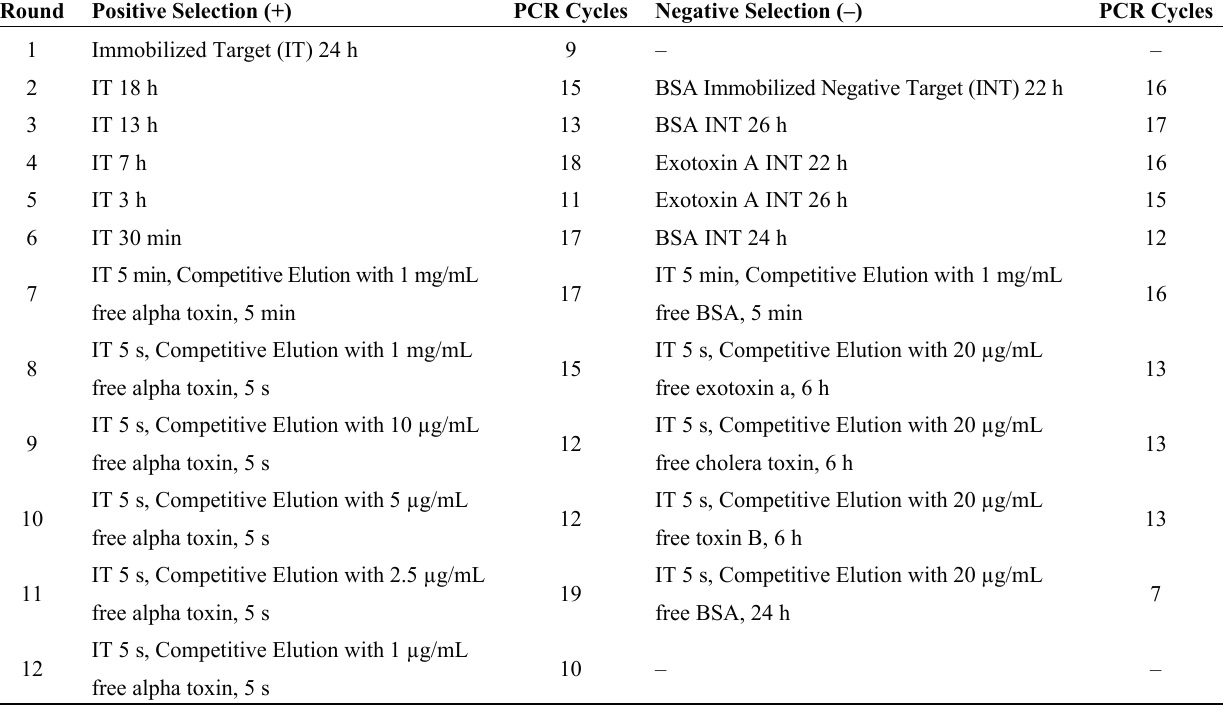
Table 1. Systematic Evolution of Ligands by Exponential Enrichment (SELEX) scheme for ssDNA molecular recognition element (MRE) identification against alpha toxin.